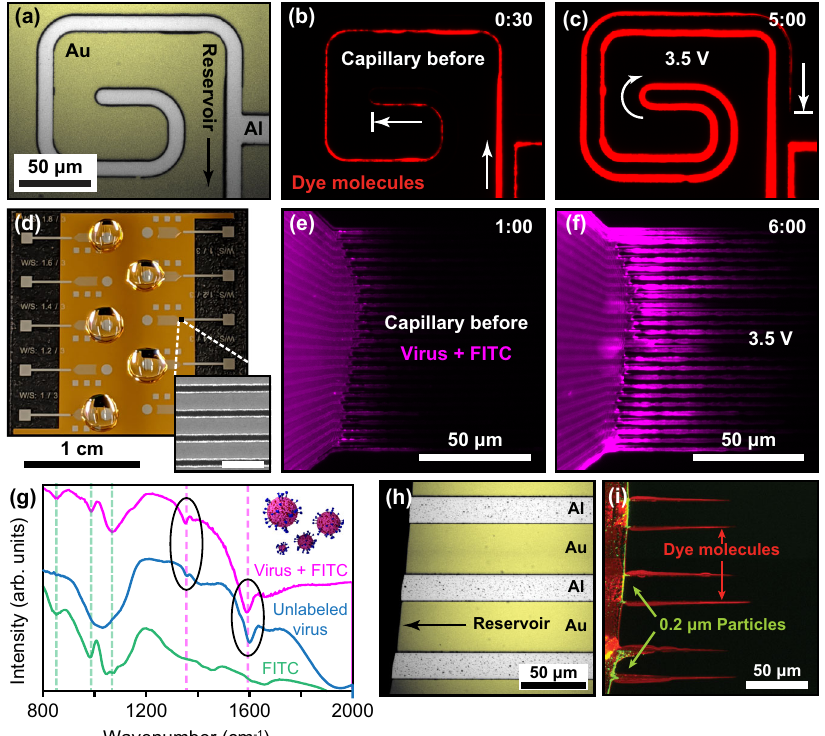
Fig. 3 Fluidic applications demonstrating high channel-density parallelization and low-loss viral biosensing. a A spiral-top electrode is patterned out of aluminum, with the bottom gold electrode colored yellow. A drop of PBS is positioned out of view. b Using the device shown in ( a ), spontaneous capillary fl ow is observed using a fl uorescent dye due to a sidewall exceeding the capillary limit. The liquid channel travels ~684 µ m from the drop. c After 3.5 V voltage is applied, the liquid channel wraps around the outer edge of the top electrode and travels an additional ~566 µ m in 5 min., for a total length of ~1.25 mm from the drop and 5 µ m in width. d An image of a sample chip with fi ve droplets placed for actuation. The inset shows an SEM image of a dense line-array used for channel parallelization (scale bar = 5 µ m). e , f Fluorescent image of parallel fl uidic channels used to extrude FITC-labeled norovirus-like particles, before ( e ) and after ( f ) voltage is applied. Images were arti fi cially colored magenta to distinguish from other experiments. g Infrared spectroscopy was used to con fi rm the presence of viral material within the channels compared with fl uorescent background. Dips unique to the virus samples are circled in black. Source data are provided as a Source Data fi le. h Three parallel top electrodes with larger separation were used for particle fi ltration. i After applying 3.5 V RMS , parallel microchannels formed along the edges of the top electrodes, as con fi rmed using fl uorescent Alexa Fluor-594 molecules (red). Larger 190-nm polystyrene beads (green) spiked into the solution are fi ltered from entering the microchannels due to low-voltage